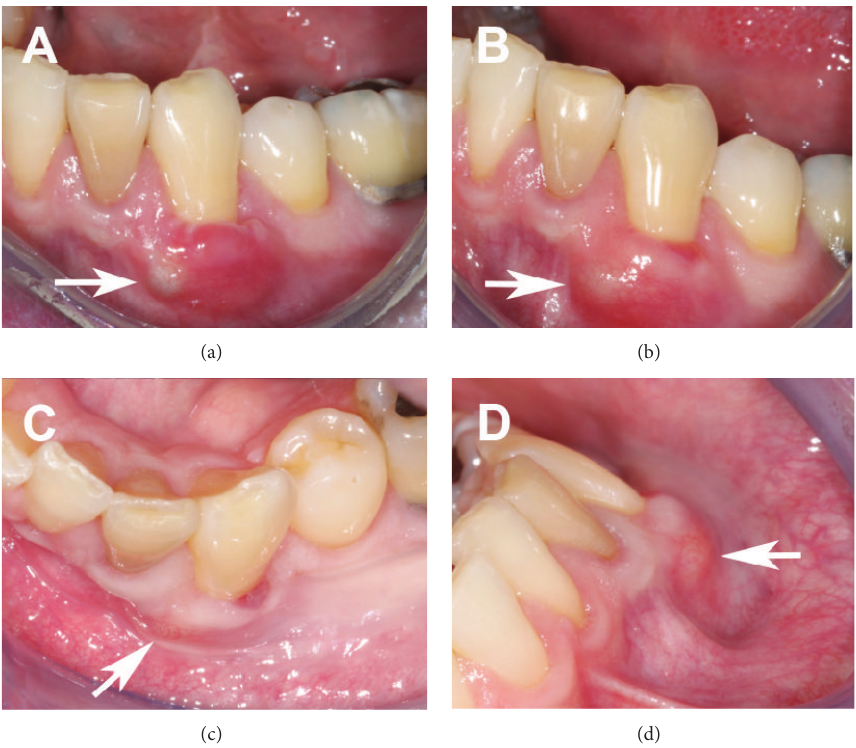
Figure 2: Clinical images. (a) Postoperative week 3 presentation; note lesion on mesial aspect of treated recession defect (arrow); (b–d) postoperative week 6 presentation; lesion (arrow) evident from direct (b), occlusal (c), and profile (d) view.